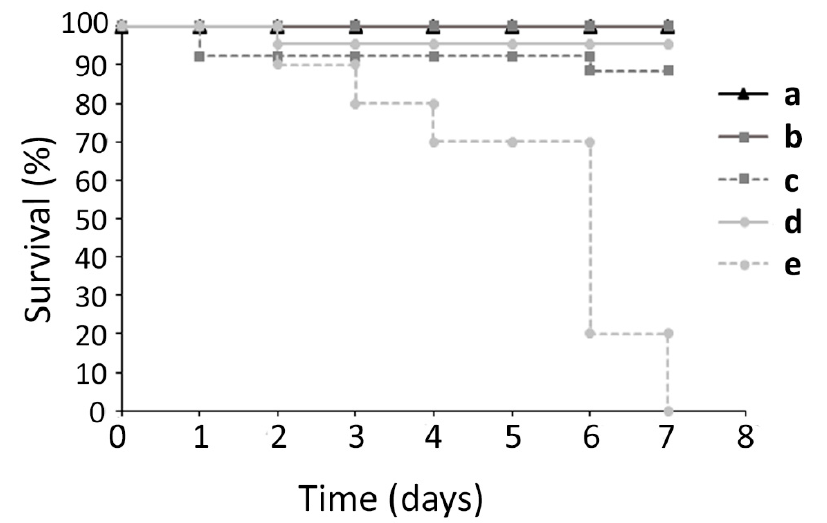
Figure 9. Kaplan-Meier survival-curve of G. mellonella larvae injected with: (a) PBS, (b) carboxypyrano-ant extract at 25 mg/kg, (c) carboxypyrano-ant extract at 50 mg/kg, (d) carboxypyCy-3-glc at 25 mg/kg, and (e) carboxypyCy-3-glc at 50 mg/kg.